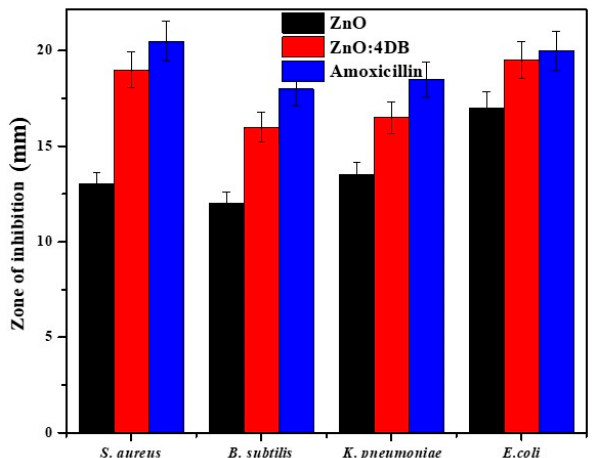
Figure 11. Comparison of the antimicrobial activity of ZnO and 4DB:ZnO nanoparticles vs. amoxicillin compound.